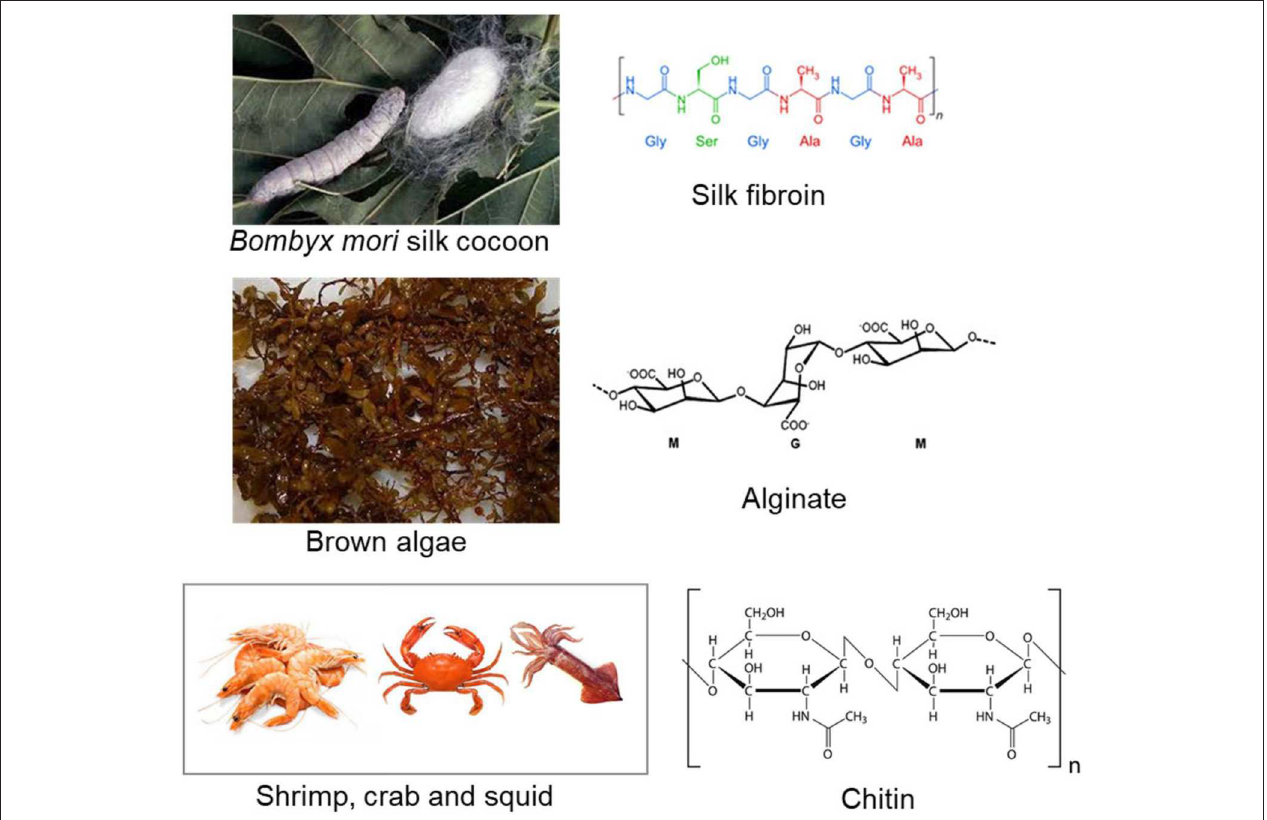
FIGURE 1 | Some natural biopolymers, derived from renewable resources, and their respective chemical structures: silk fibroin, alginate, and chitin. Reproduced from Mano et al. (2007) with permission from Copyright 2007 Royal